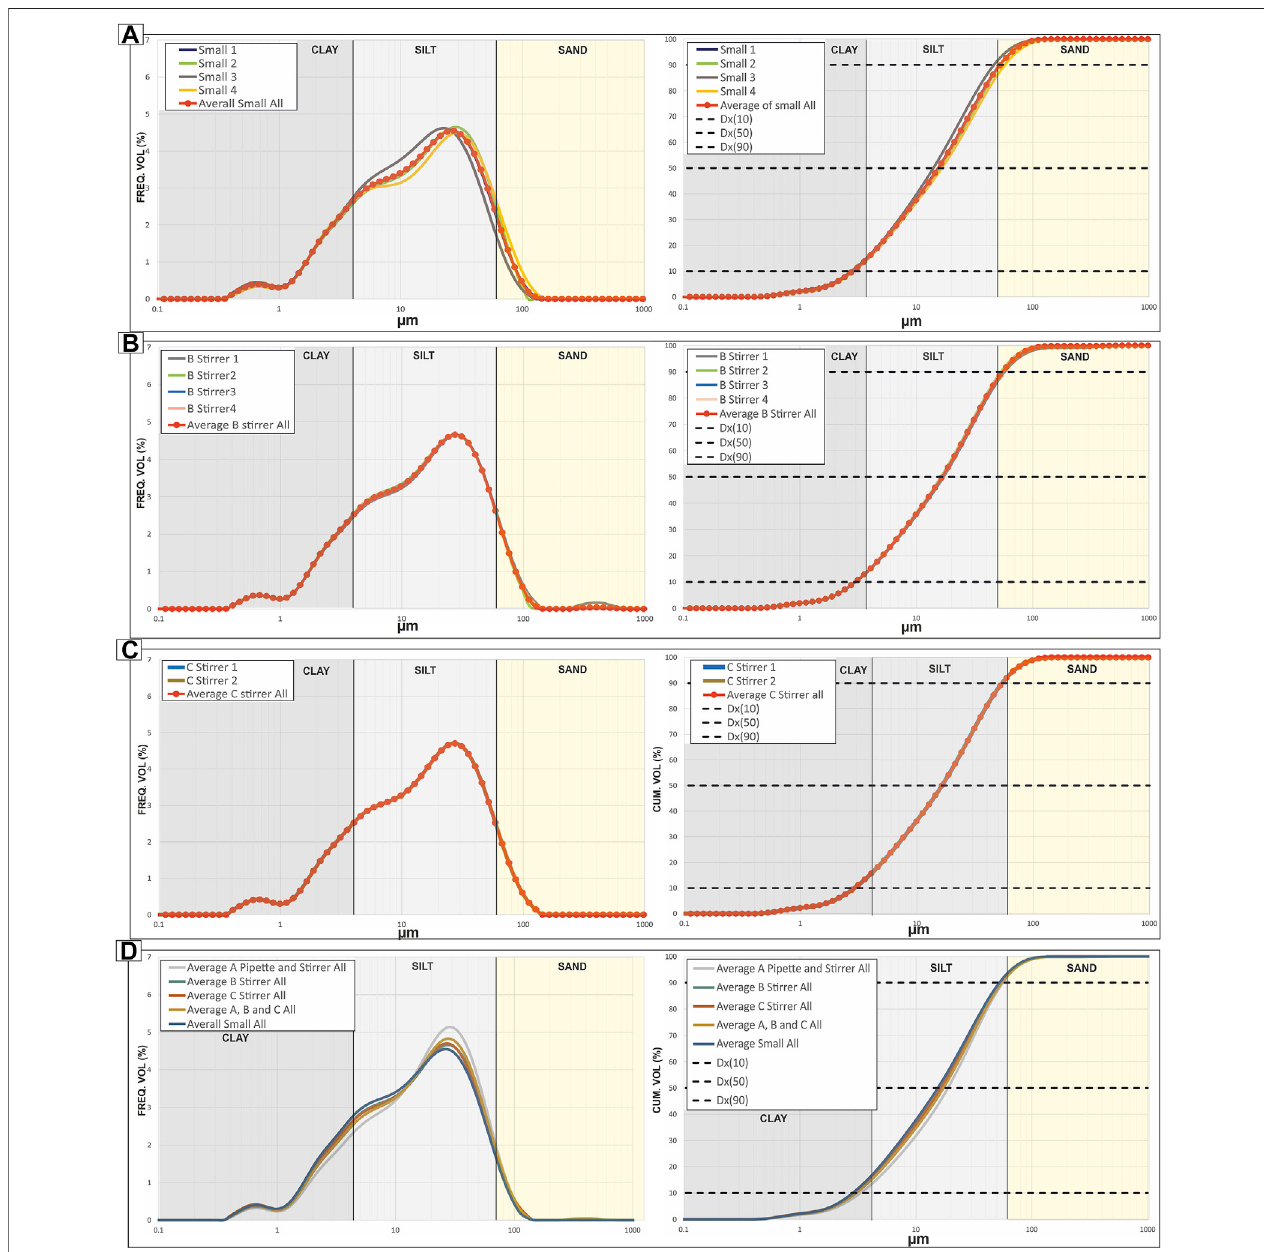
FIGURE 7 | Volume frequency and cumulative frequency of aliquots for mud-rich fi eld sample V B209 S22. These are further tests using the stirrer method and smallsamples tocompare tosubsampleA results in Figure 6 . (A) Smallsub-samples D, E, F, Gand average small sample result. (B) Sub-sample B, Stirrer aliquots1-4 and averageofaliquots. (C) Sub-sample C, Stirrer aliquots1and 2, and average ofboth aliquots (D) AveragesofsubsamplesA,B and C,comparedtoan average ofall of these sub-samples and an average of the small samples. For detailed results Supplementary Table S1 , for p -values Supplementary Table S2 .